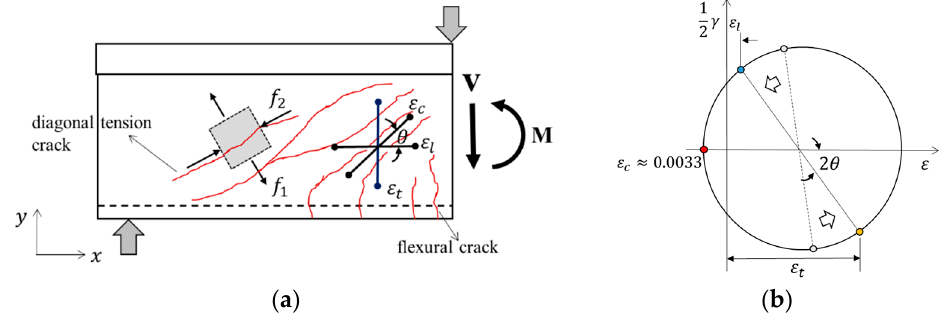
Figure 3. Strains in the web element. ( a ) Longitudinal, transverse, and compressive strut strains. ( b ) The transverse strain increased when the angle of inclination was reduced (Mohr circle).